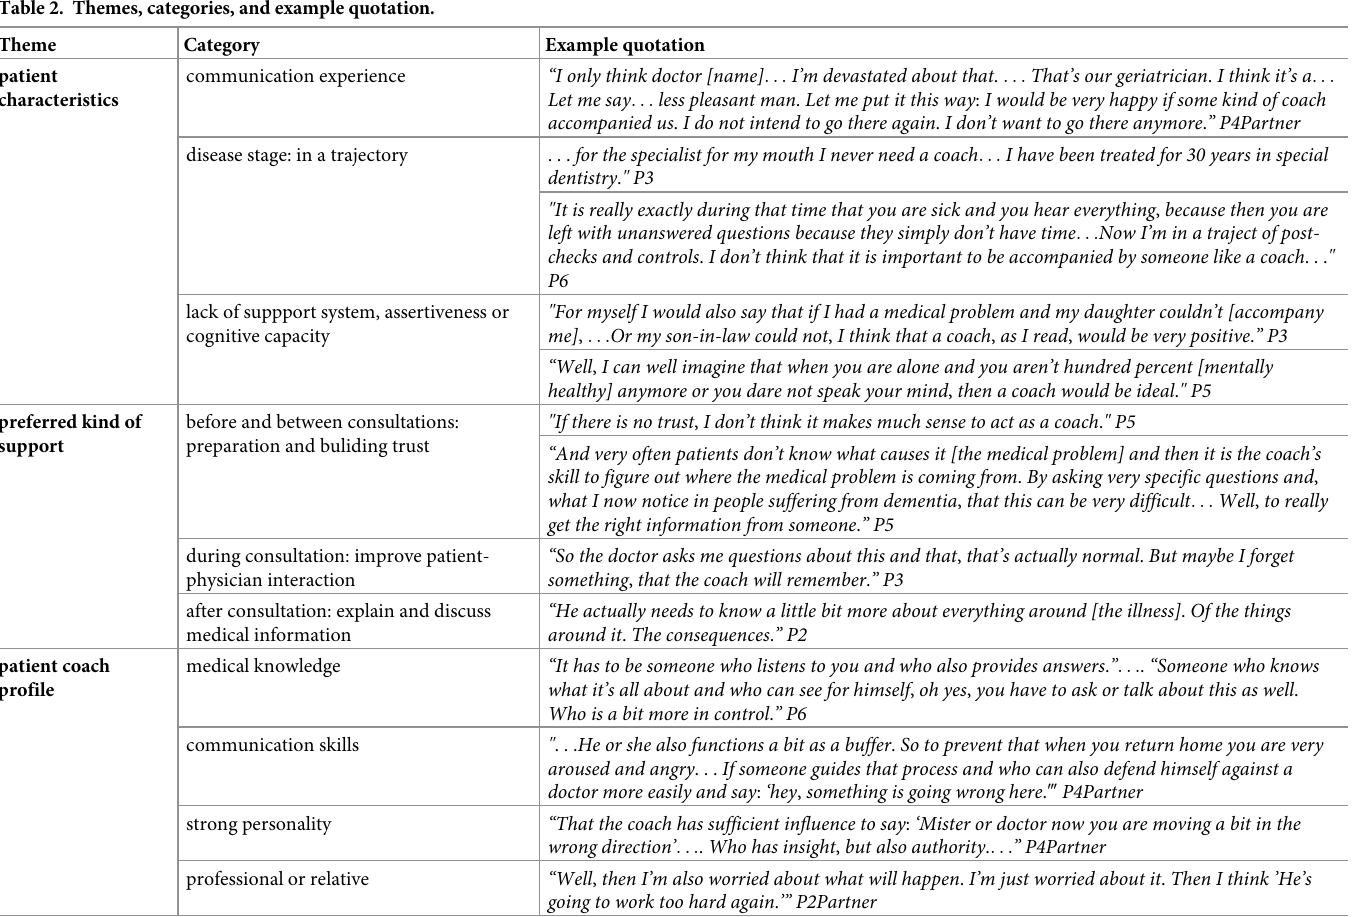
Table 2. Themes, categories, and example